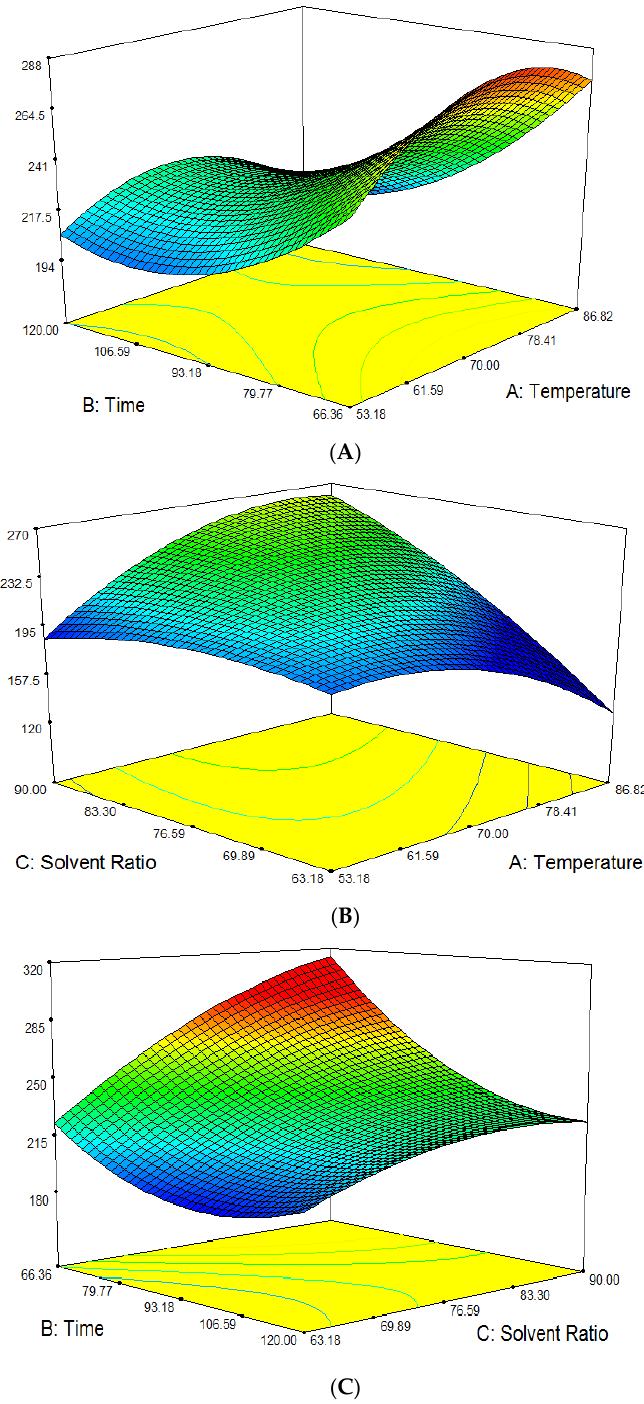
Figure 4. Response surface (3D) on the effect of extraction temperature, ethanol concentration and extraction time on TPC of P. macrocarpa fruit extract. ( A ) Total Phenolic Content (mg/g); ( B ) Total Phenolic Content (mg/g); ( C ) Total Phenolic Content (mg/g).